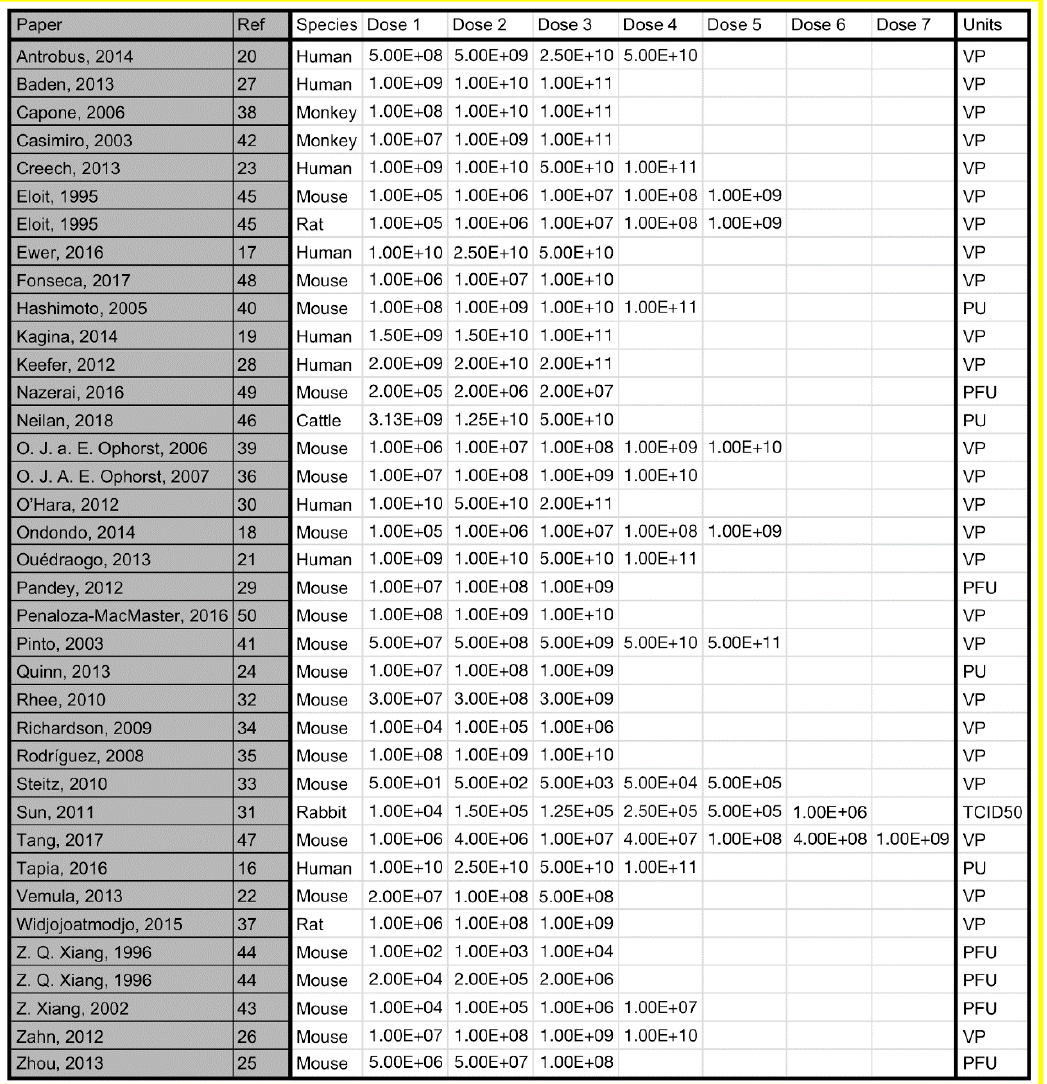
Figure A2. Dose magnitudes for the collected studies, including the name of the paper, the host species, and the unit used to quantify dose.